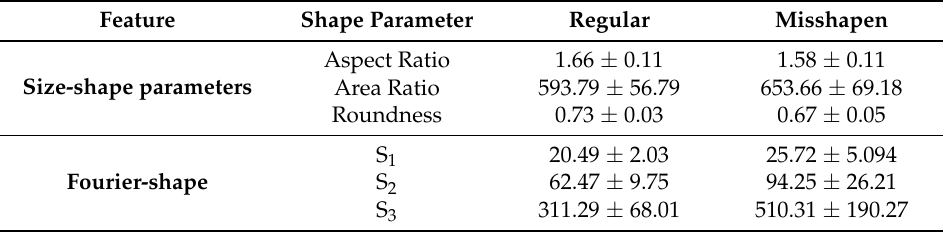
Table 2. Shape features (means + standard deviation) of regular and misshapen mango.